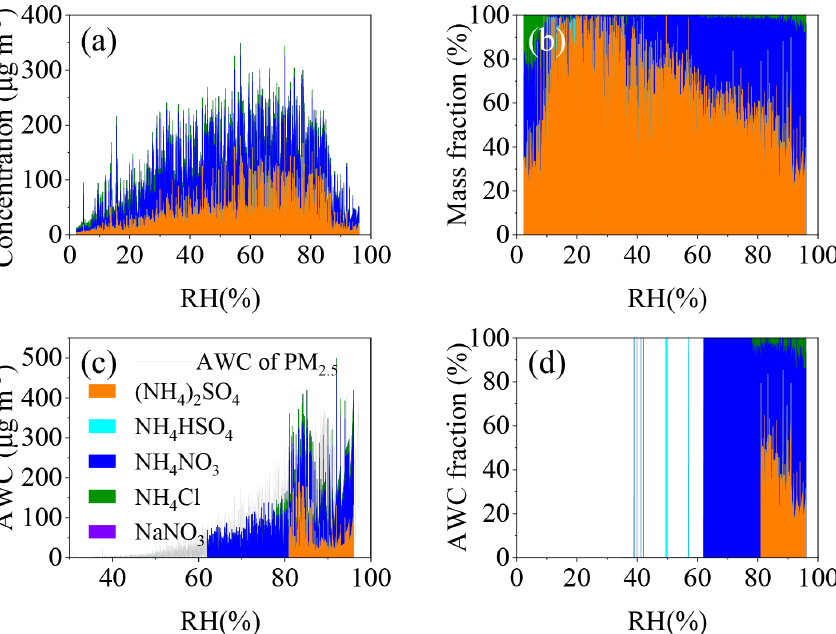
Figure 5. Variations of (a) the mass concentrations and (b) the mass fractions of molecular composition in PM 2 . 5 , (c) the estimated AWC attributed to different composition and (d) the corresponding AWC fraction as a function of RH in